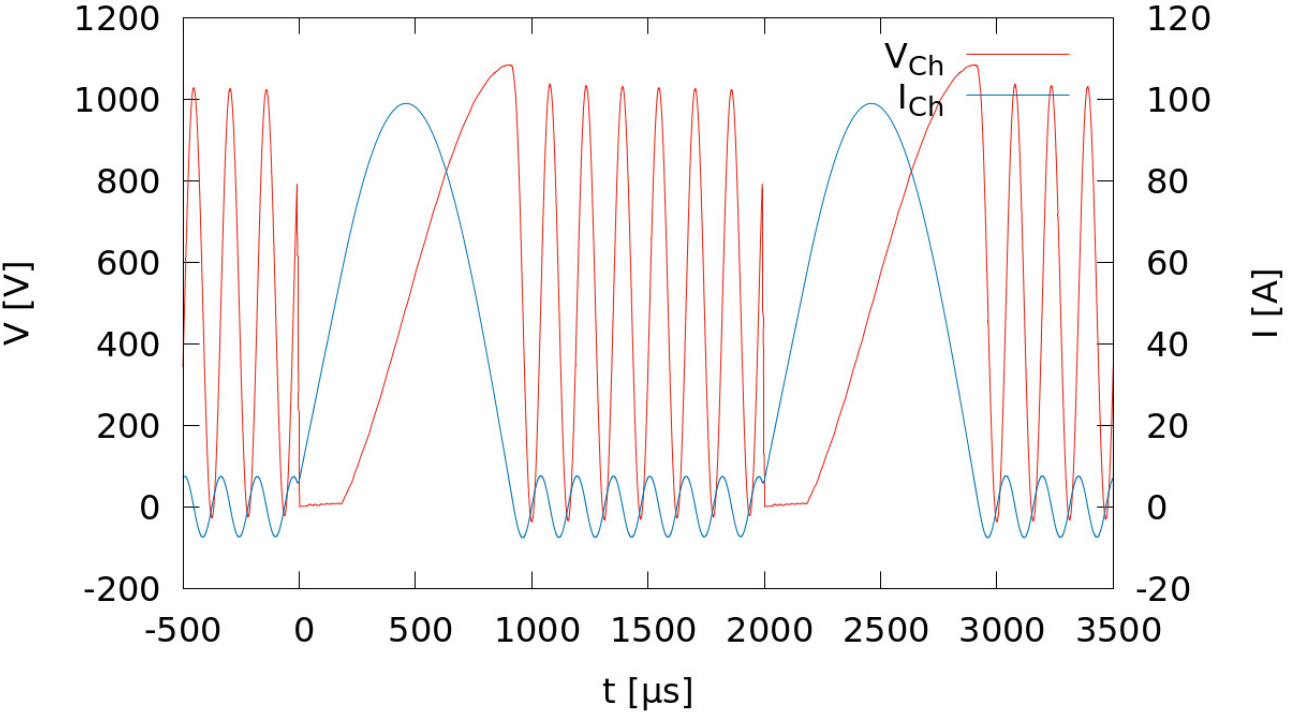
Figure 15. Energy stored in the cores of two current-compensated chokes (W Core ) and common-mode current I C through the chokes (Simulation for current-compensated chokes comprising L1, L2 and L3, L4 according to Figure 3, R D = 20 Ohm, on-time of the solid-state switches: t on = 200 µs).